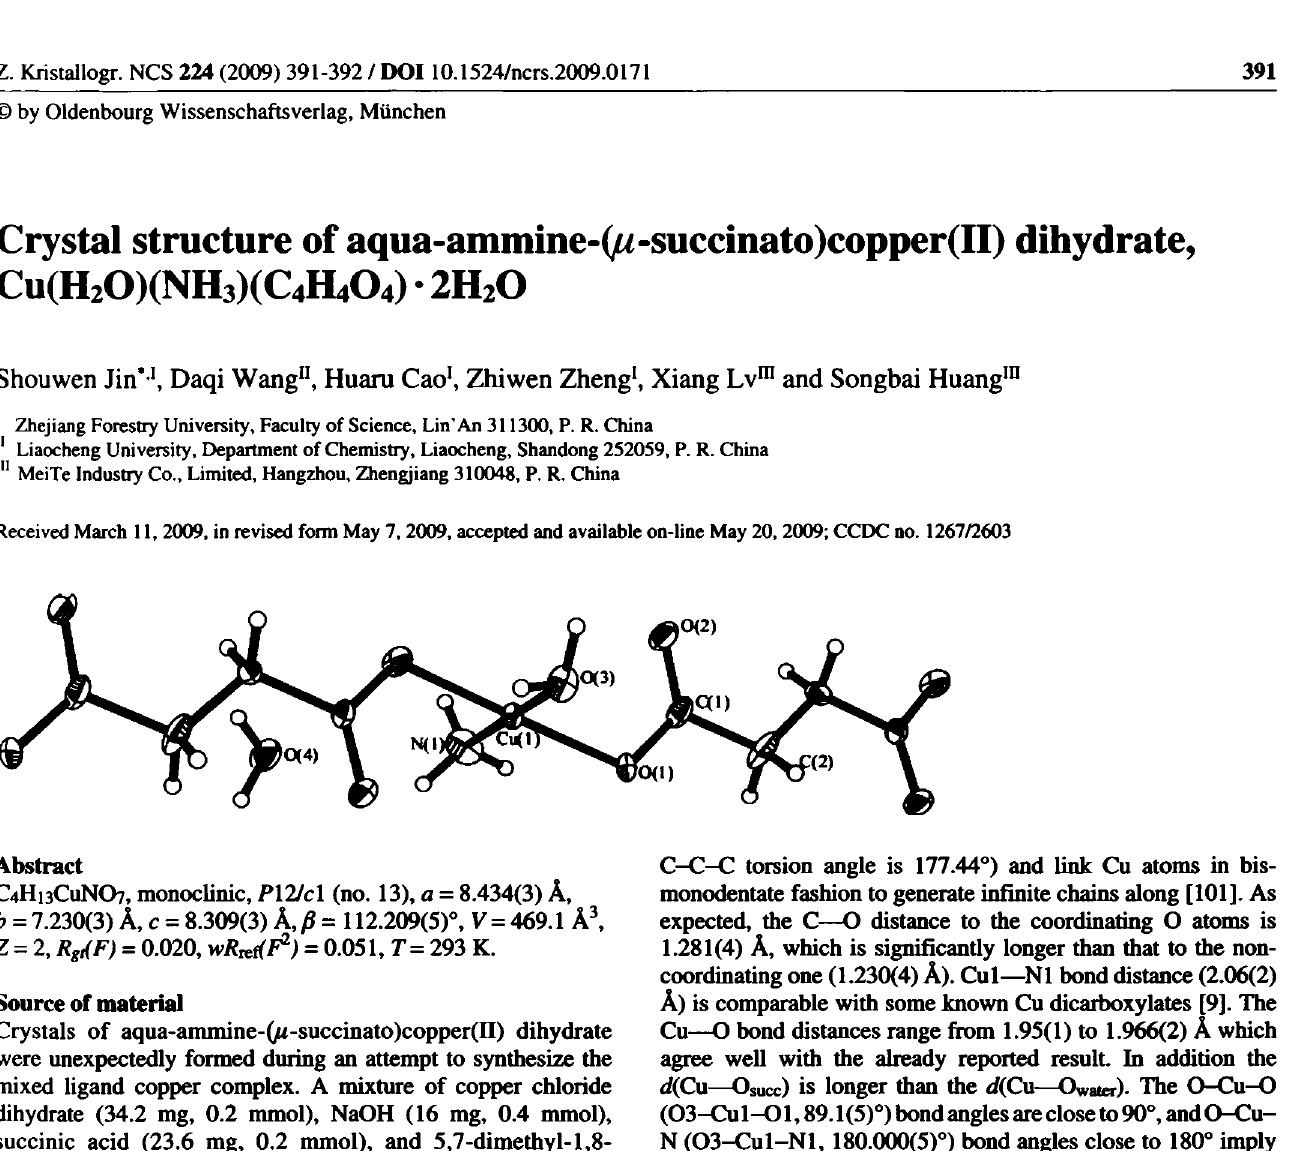
Table 1. Data collection and handling. Crystal: